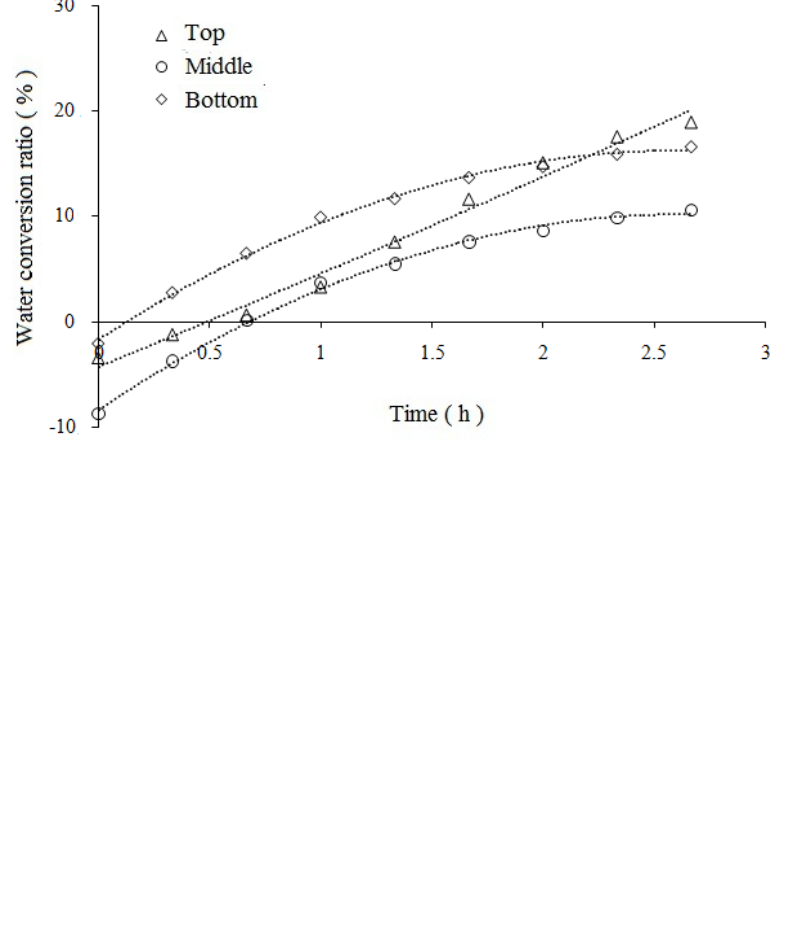
Figure 10. Amplitudes of 2–5 h period in Figure 9 (for the same reason as in Figure 6, 2 h, 5 h in Figure 9 were respectively translated into 0 h, 3 h. Top: water conversion ratio = 0.0017 × reaction time 2 + 0.0868 × reaction time – 0.0426, R 2 = 0.9864; Middle: water conversion ratio = −0.027 × reaction time 2 + 0.1414 × reaction time − 0.0833, R 2 = 0.9969; Bottom: water conversion ratio = −0.026 × reaction time 2 + 0.1368 × reaction time − 0.0166, R 2 = 0.9969. Reaction time only implies the horizontal axis in Figure